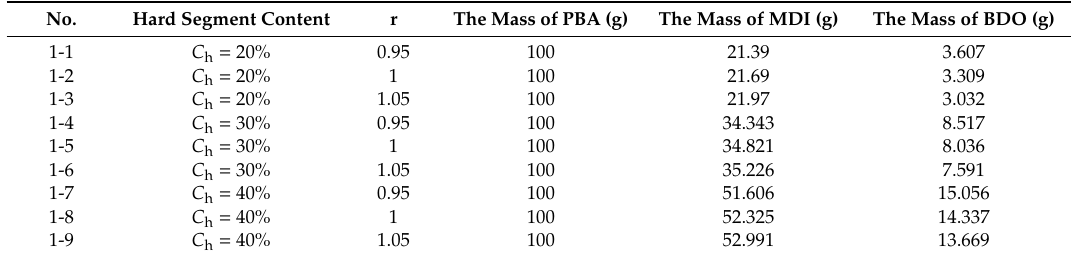
Table 1. Composition and hard segment content of polyester-based TPUs.